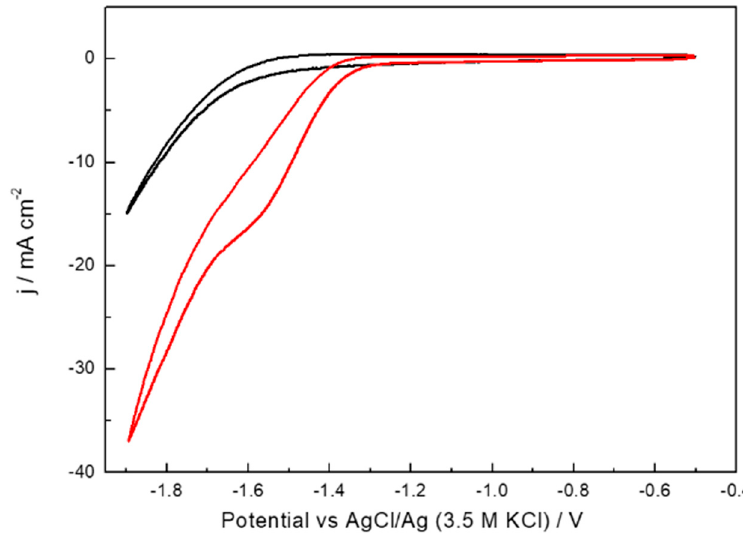
Figure 3. Cyclic voltammetry response of Bi / C electrode with Bi loading of 0.1 mg cm − 2 in Ar (black line) and CO 2 (red line) saturated 0.5 M KHCO 3 . Scan rate 50 mV s − 1 .